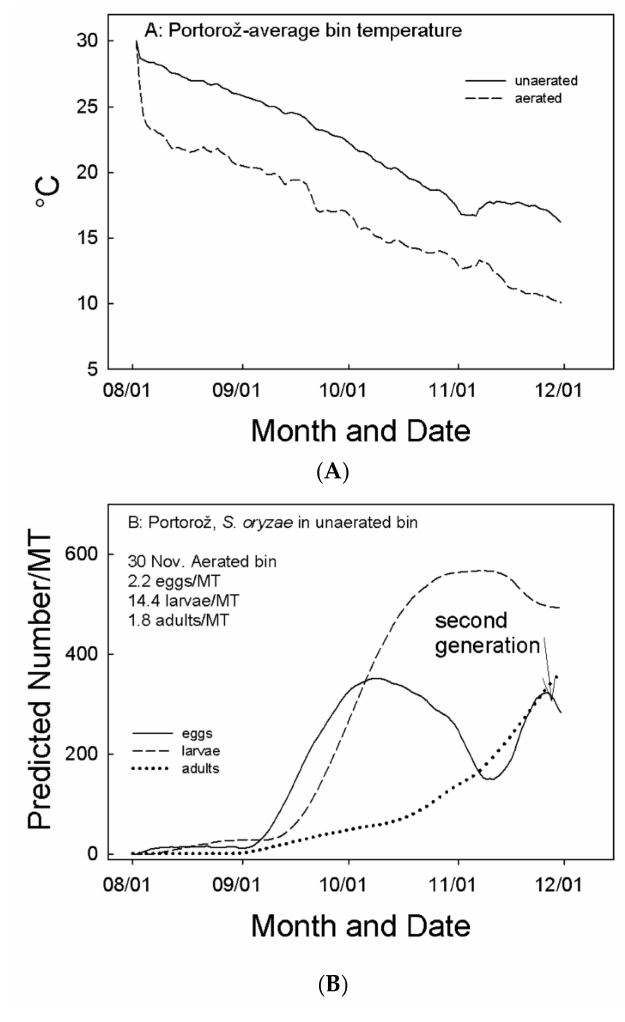
Figure 2. Predicted average bin temperatures in unaerated and aerated wheat stored in Portorož, Slovenia from 1 August to 30 November ( A ); and predicted numbers of eggs, larvae, and adults of Sitophilus oryzae in unaerated wheat ( B ). Predicted numbers of each life stage on November 30 in aerated wheat are listed as text ( B ). In the X-axes, date is given in Month-Day